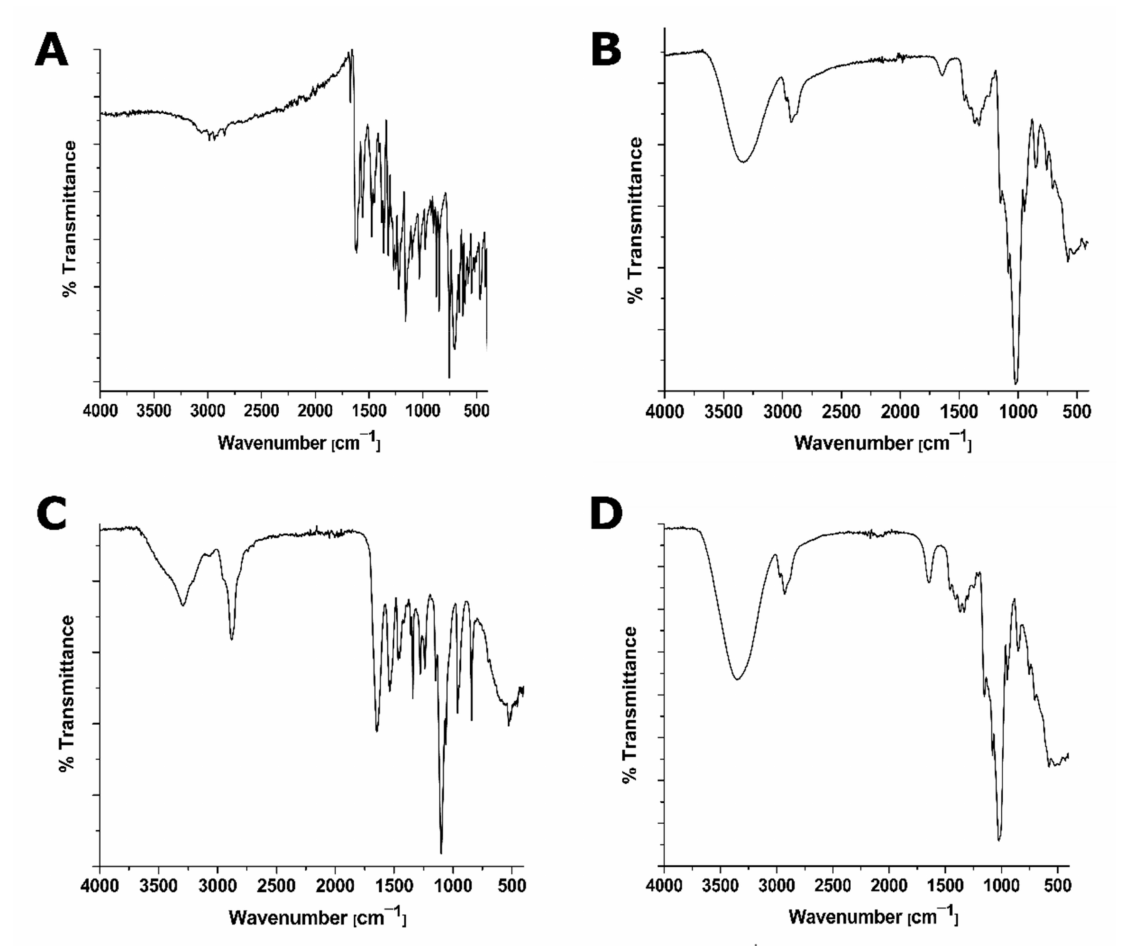
Figure 4. FT-IR spectra of ( A ) PTN, ( B ) HP- β -CD, ( C ) physical mixture (1:1 molar ratio of PTN and HP- β -CD), and ( D ) PTN/HP- β -CD complexes over the wavenumber range 4000–400 cm − 1